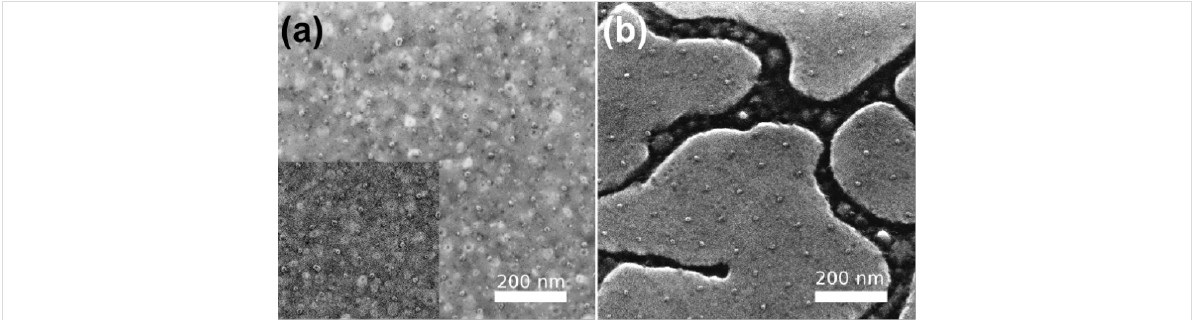
Figure 2: SEM images of Co NPs on Pt(111)/MgO(100) and Pt(100)/STO(100) are displayed in panels (a) and (b), respectively. Co particles are oxidized due to ex-situ transport. For better contrast of NPs three quarters of panel (a) is strongly filtered while in the lower left quarter the original SEM image is displayed.